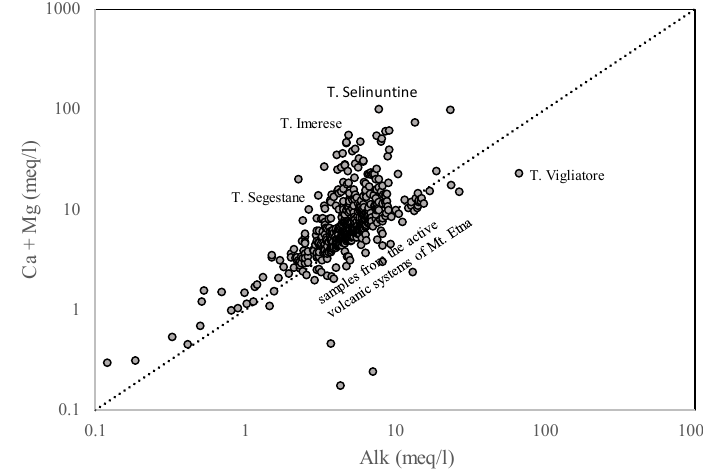
Figure 2. (Ca + Mg) vs. total alkalinity (Alk) concentration expressed as meq · L − 1 in log scale. PPs for sodium (Na) and chlorine (Cl) show a similar distribution for low concentrations with three inflection points, reflecting four populations of data: about 47% of samples show an intermediate concentration group (population II), and a reduced group (about 1%) shows higher concentrations (population IV). Only sodium shows an additional population with strongly anomalous values (population V), the sampling points of which (Naftia, Terme Selinuntine, Terme Vigliatore, T. Imerese, Sclafani Bagni, G. Cassibile) are in some cases located where volcanic or hydrothermal activity has been identified [10,24,25]. In the diagram of Na-Cl (Figure 3), samples containing seawater contributions can